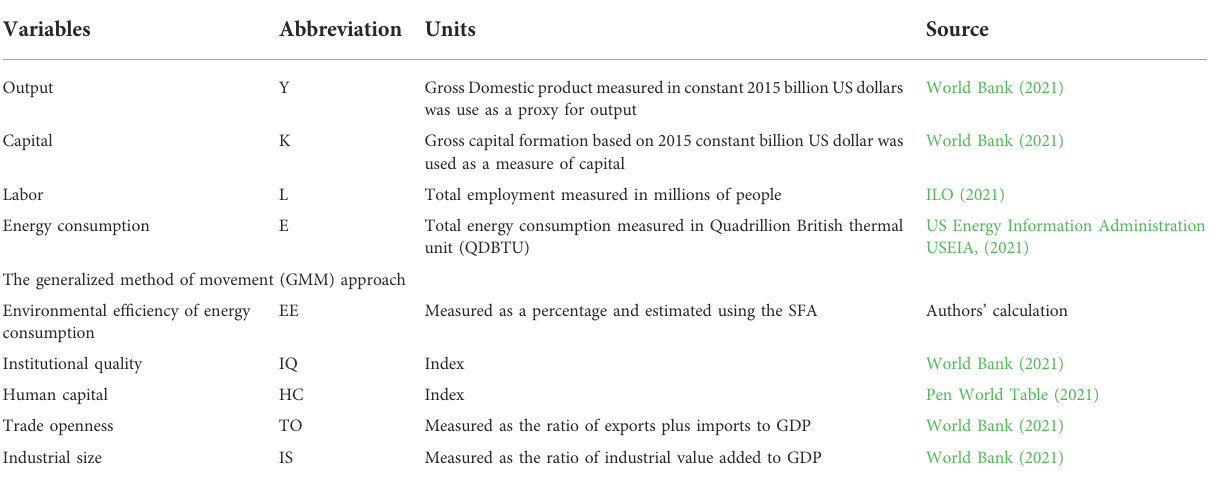
TABLE 1 Explanation of variables and data